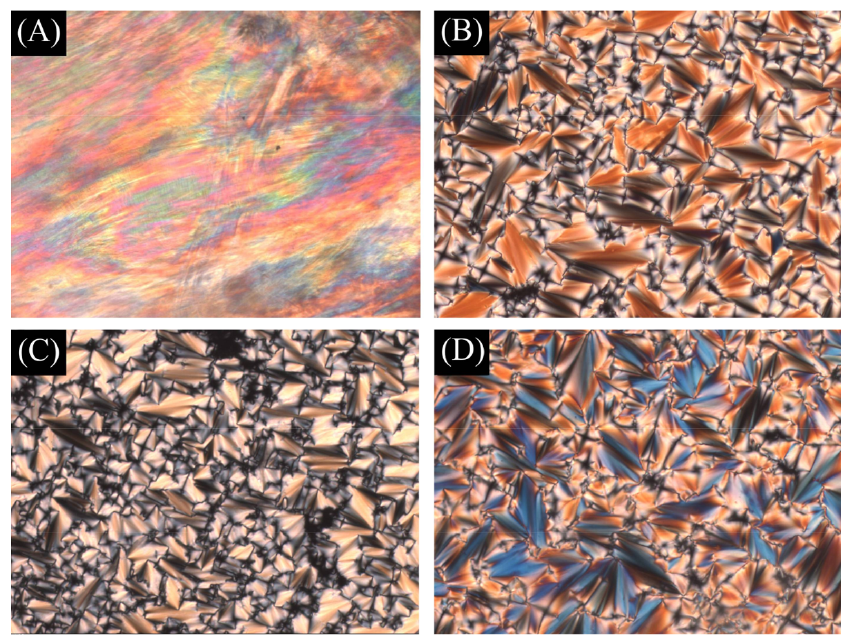
Figure 3. Polarizing optical microscope (POM) texture of the LC copolymers (200 × ). Polarizing optical microscope (POM) texture of the LC copolymers. ( A ) LC texture of a SmA phase